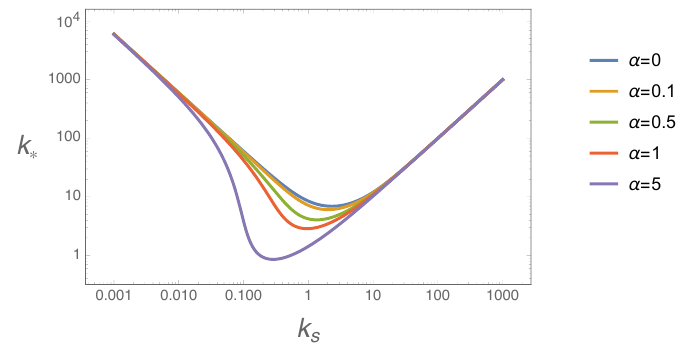
Figure 1 . The loglogplot of k (cid:3) as a function of k s at di(cid:11)erent values of (cid:11) . The behaviour of k (cid:3) at small k s or large k s is independent of (cid:11) . Note that one can always (cid:12)nd a solution of k (cid:3) at arbitrary (cid:11); (cid:21) and this means that the instability always exists whenever (cid:21) 6 = 0. (cid:15) When j k j < j k j , the mass squares in (3.19) are real. We have m 2 (cid:3)